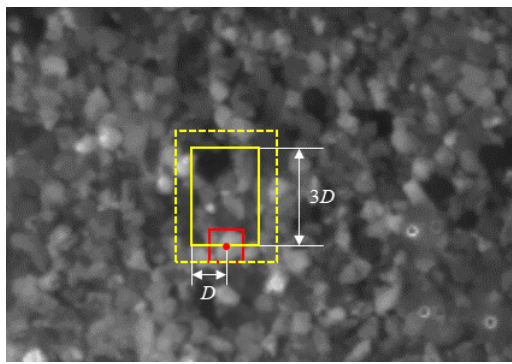
Figure 5. The diagnostic window (red square) and searching area (yellow square). (2) Determination of particle position.